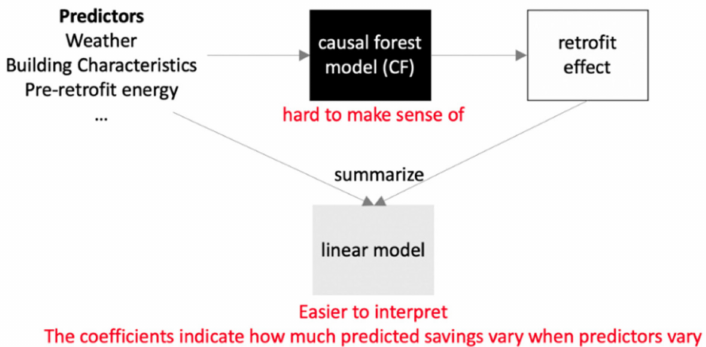
Figure 16. Schematic diagram of summarizing a causal forest with a linear model (linear